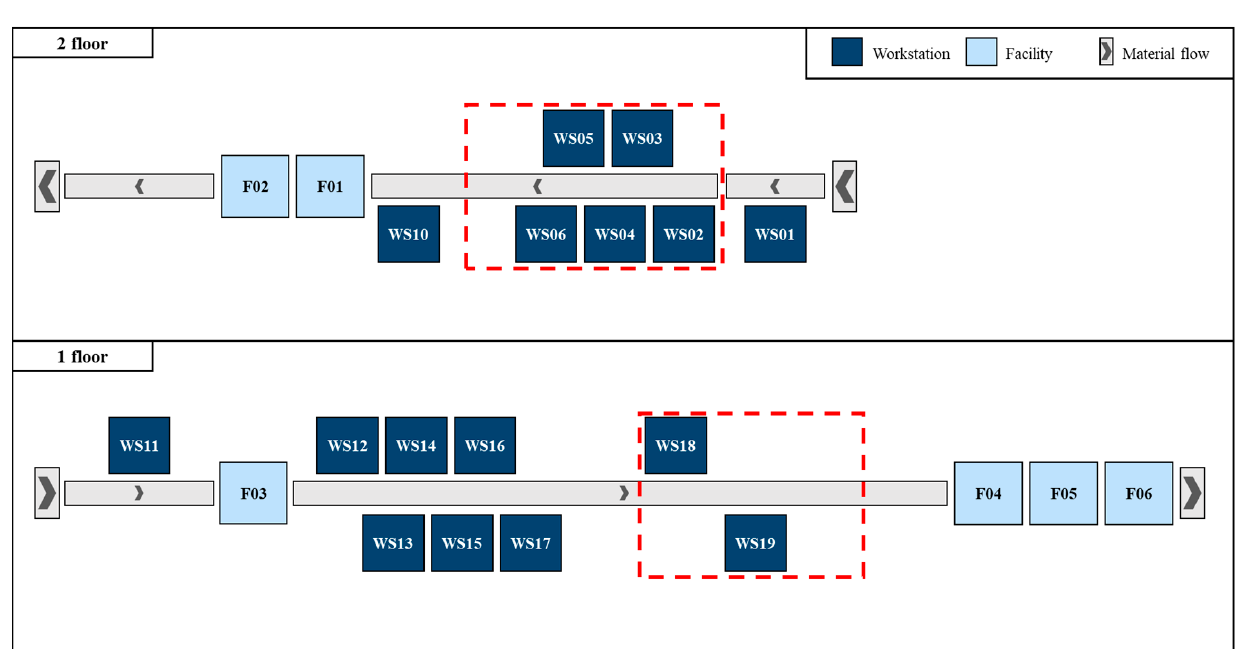
Figure 6. Layout image before optimization.